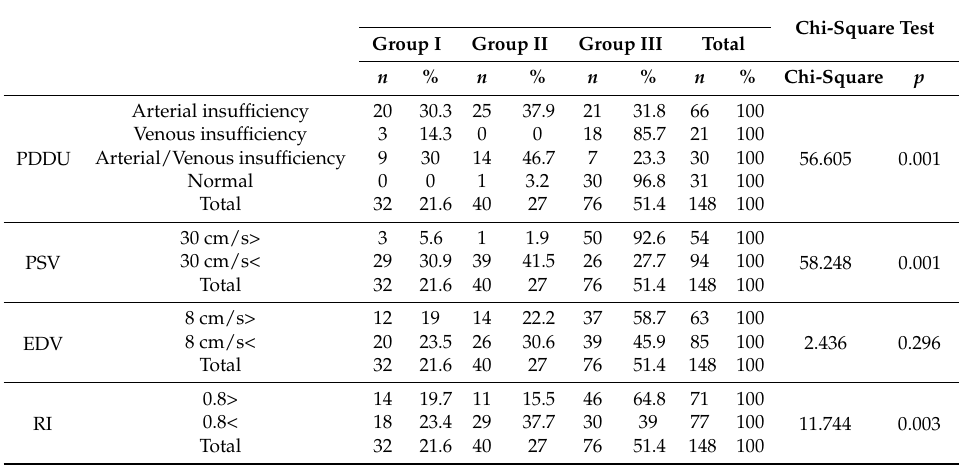
Table 3. Distribution of the groups in terms of Doppler ultrasonography